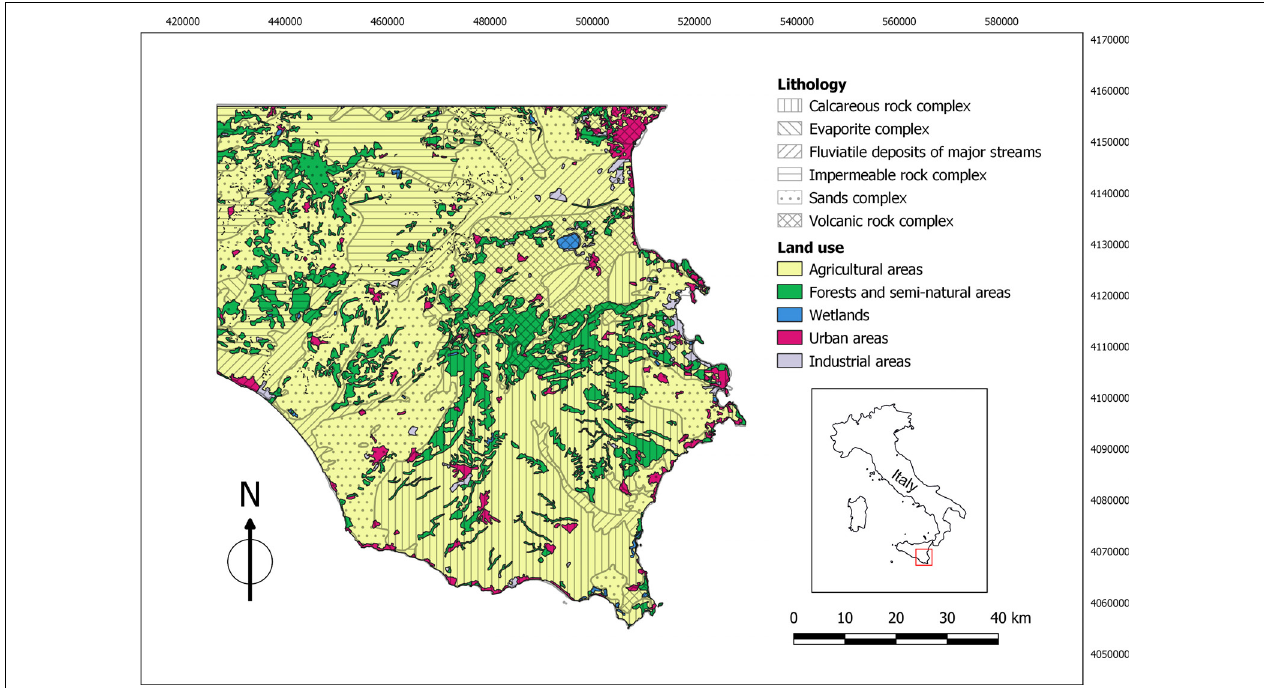
FIGURE 2 | Schematic map of the geological settings and of the use of the land in Hyblean area. Geological data modified from Carbone et al. (1987); land use data from http://www.sitr.regione.sicilia.it/?cat=26.